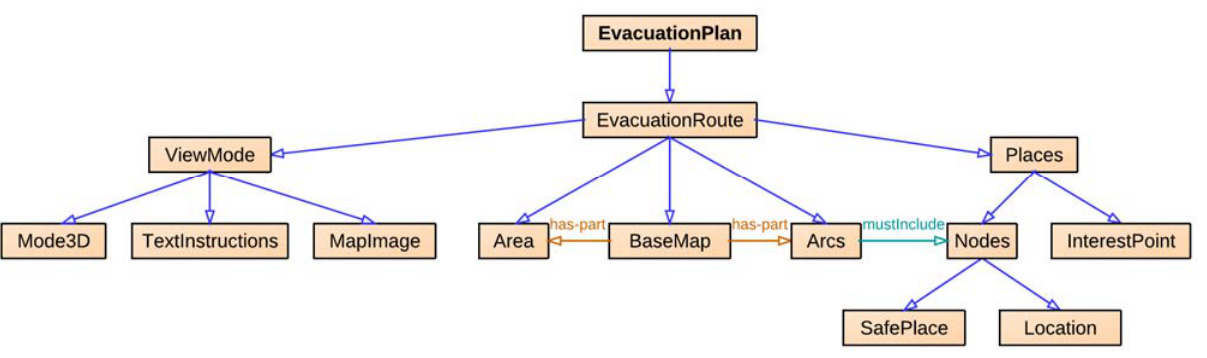
Figure 2. NERES: the evacuation plan data model.